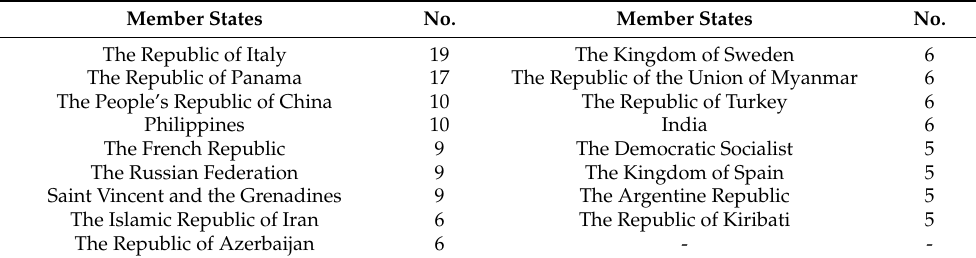
Figure 1. Time and quantity of circular letters from member states and international organizations. Table 1. Number of maritime proposals from member states (more than 5).